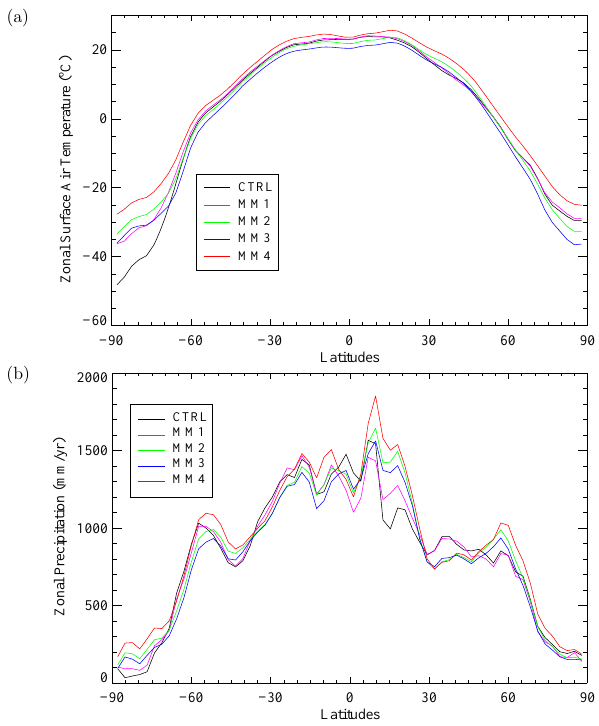
Fig. 4. Zonal average (a) surface air temperature ( ◦ C) and (b) pre- cipitation (mm/yr) for the series of simulation experiments MM1 to